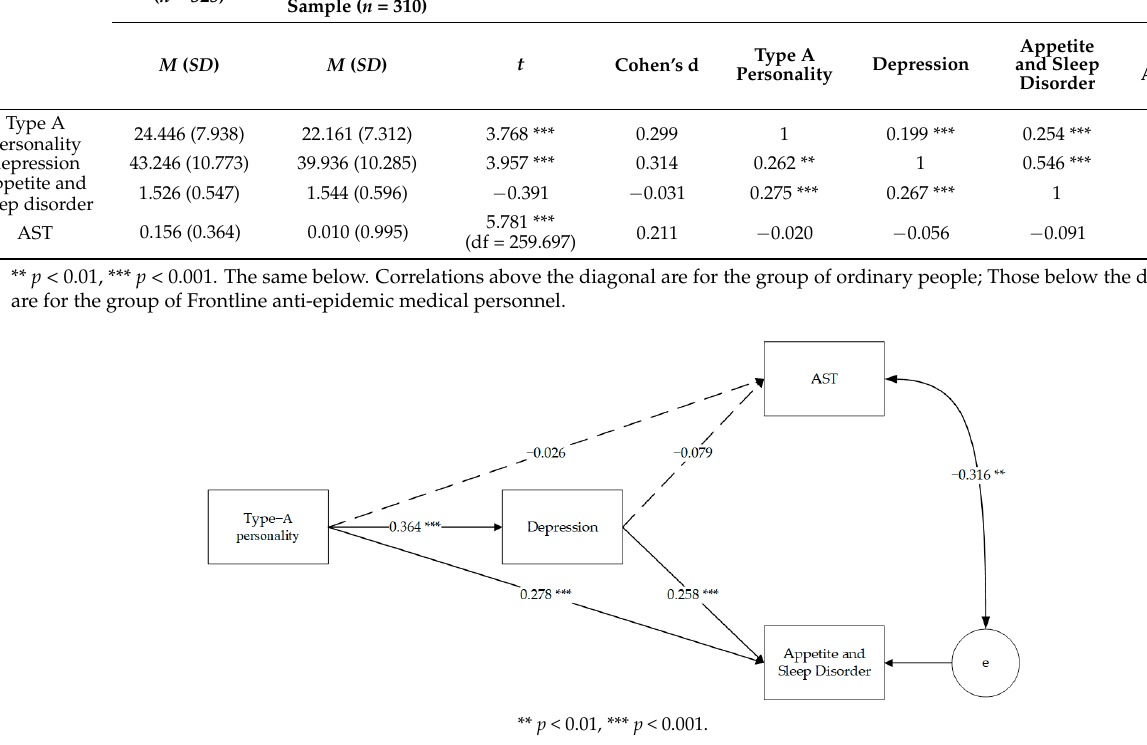
Figure 1. Path model for the group of ordinary people ( n = 325). Standardized path coefficients among variables are presented. The solid paths are statistically significant.